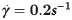
Biofilm detachment at γ˙=0.2s−1.(a) detachment cluster volume with time; (b) number of events with time; (c) distribution of detached cluster volume. The error bars show ±1 standard deviation calculated from five replicates. Results from all replicates are shown to demonstrate that they all follow the same trend.